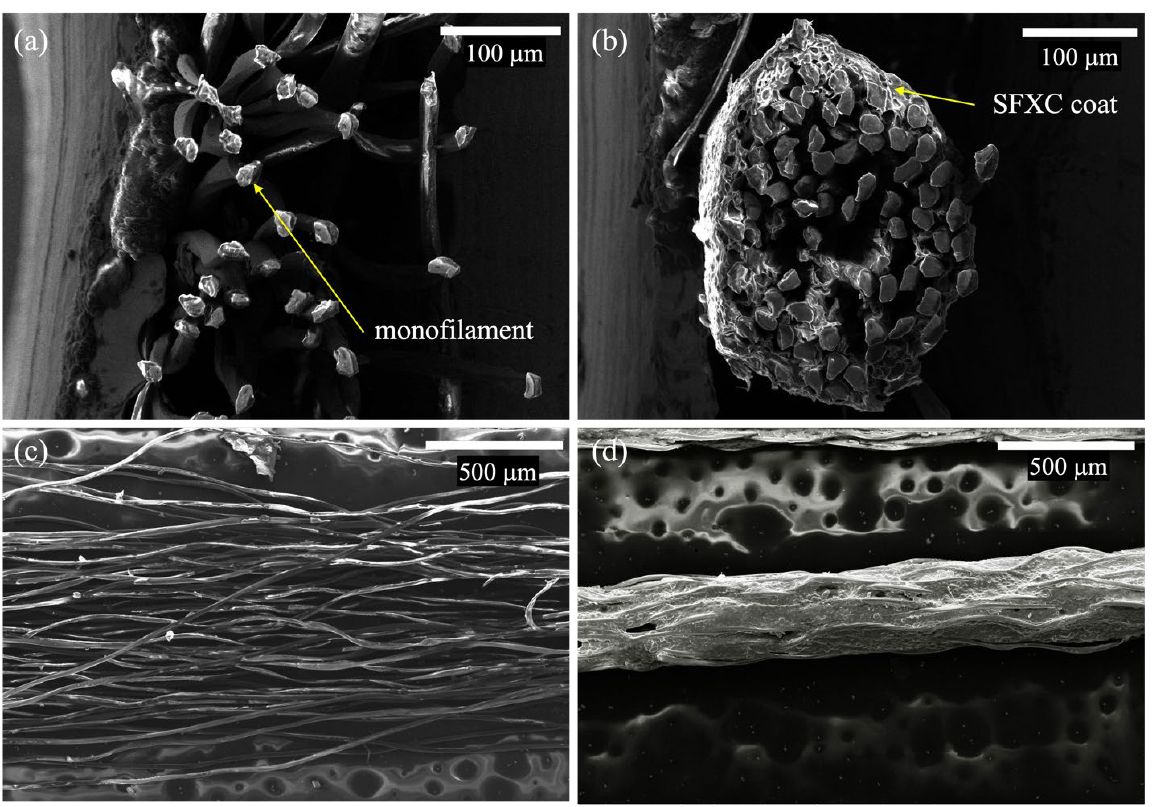
Figure 2. SEM images of multifilament Repreve yarn. Cross-section of the ( a ) splayed filaments of the uncoated yarn and ( b ) coated with SFXC liquid crystal. Longitudinal (side-on) images of the ( c ) uncoated and ( d ) coated yarn.